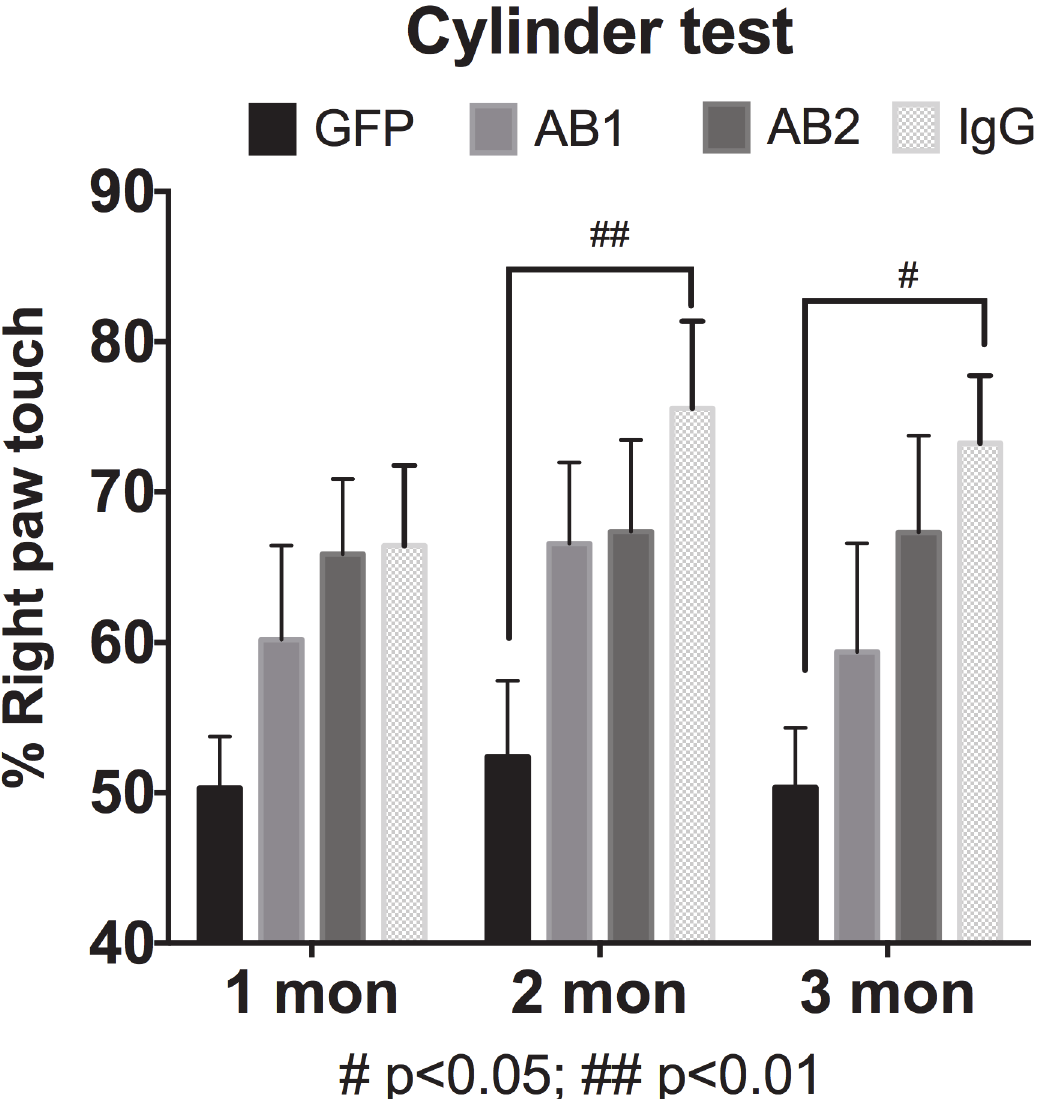
Fig 2. Effect of intraperitoneal administered anti- α -Syn antibodies on motor function. AAV- α -Syn+IgG rats demonstrated paw bias in the cylinder test when compared with AAV-GFP controls starting at two months and continued at 3 months, likely reflecting the progressive nature of this model with ongoing DA cell loss (A two-way ANOVA found a main effect of treatment, F 3,67 = 4.48, p = < 0.001). Although AB1 or AB2 antibody treatment did not demonstrate any significant improvement in behavioral deficits compared to AAV- α -Syn+IgG treated animals, at no time was the AB1 nor AB2 group significantly different from the control AAV-GFP group. Data are presented, as the percent right paw preference ± SEM (n = 23 AAV-GFP control and n = 16 for treatment groups).